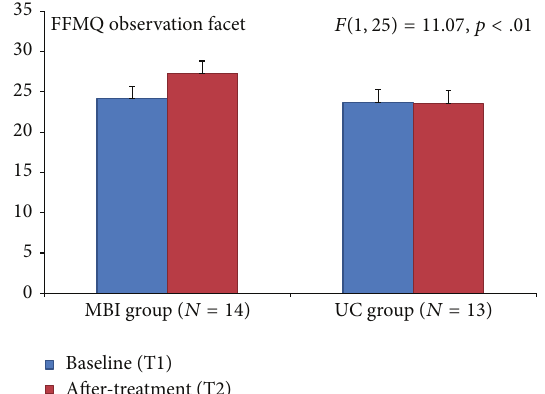
Figure 2: Five Facet Mindfulness Questionnaire (FFMQ) for obser- vation facet showed a significant effect for the MBI